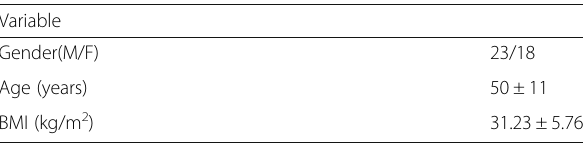
50 ± 11 31.23 ± 5.76